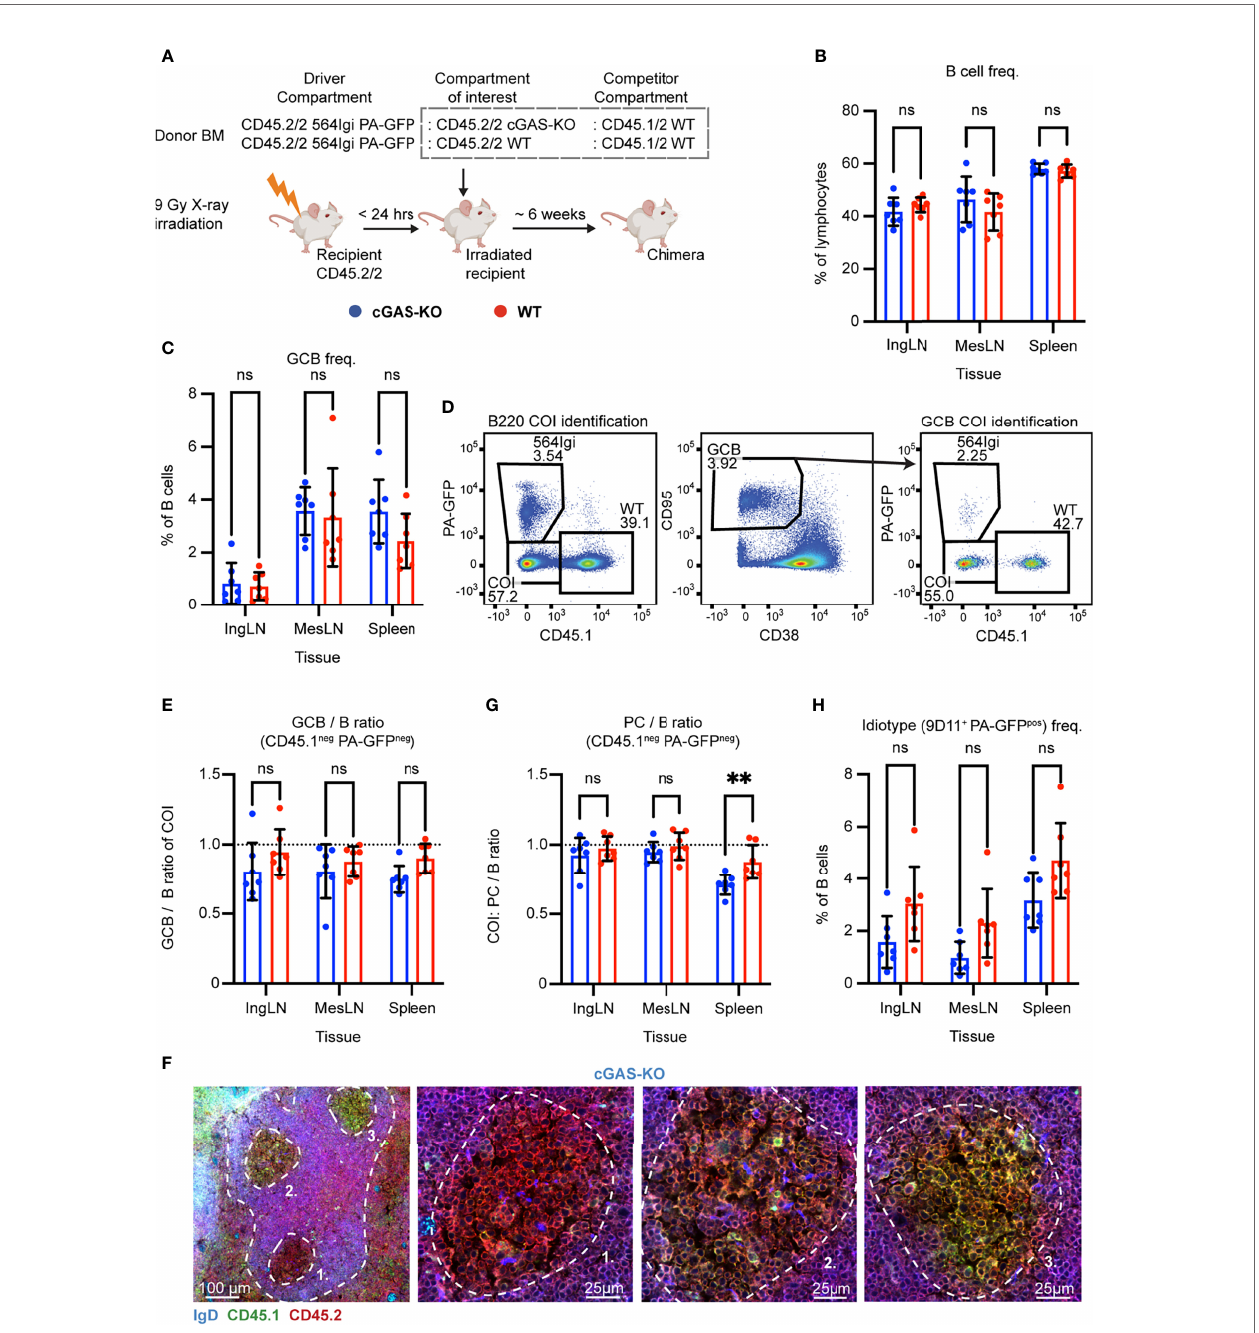
FIGURE 5 | B cell intrinsic cGAS signaling is not required for autoreactive germinal center participation but marginally impacts PC output in the spleen. (A) Schematic overview of experimental setup with timeline. (B) B cell frequencies out of live, singlet lymphocytes, in lymphoid tissues of cGAS-KO (blue, n = 7) and WT (red, n = 7) chimeras. Each dot represents an individual mouse and bars indicate mean +/- SD, with statistical signi fi cance given for two-way ANOVA followed by Sidak ’ s post- test ( a = 0.05), ns = not signi fi cant, ** = p<0.01. (C) As in (B) , but for GCB cell frequencies instead. (D) Representative example from a cGAS-KO chimera showing gates used to de fi ne CD45.1 vs. PA-GFP within the B cell (left) and GCB cell (right) compartments, and the parent GCB cell gate (center). (E) As (B) but showing relative GCB to B cell ratios for the compartment of interest (COI, CD45.1 - PA-GFP - ). (F) Confocal micrographs of spleen sections from a representative cGAS-KO chimera stained for IgD (naïve B cells, blue), CD45.1 (green), CD45.2 (red) and the marginal zone (CD169, not shown). Left, lower magni fi cation image, with indication of the marginal zone (broken white line, based on CD169 staining, Figure S5K ) and three GCs (numbered). Subsequent panels present higher magni fi cation images of each of the three numbered GCs in the left panel. Channel assignments and brightness were adjusted to enhance visual clarity of micrographs. (G) As (E) but showing relative PC (plasma blast/cell, CD138 hi within live, singlet lymphocytes) to B cell ratios for the compartment of interest (COI, CD45.1 - PA-GFP - ). (H) As (B) , but for 564Igi idiotype (9D11 + ) frequencies of PA-GFP positive B